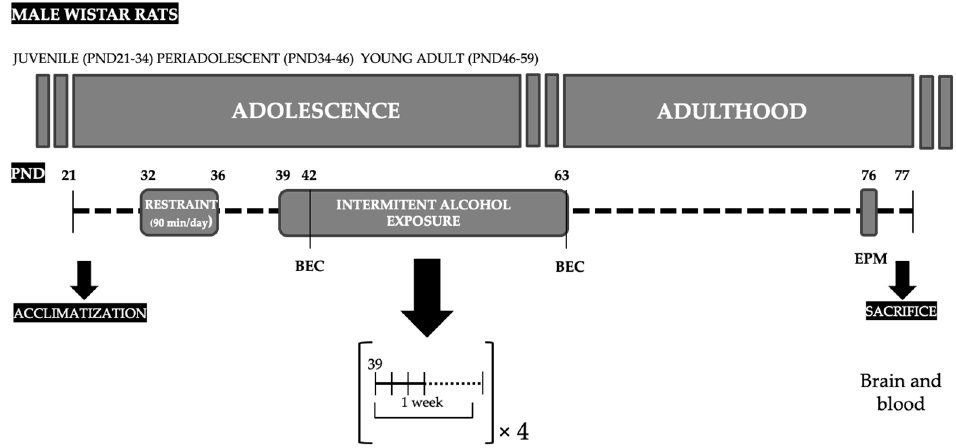
Figure 1. Experimental design of the study. Adolescent male rats were exposed to a repeated restraint stress (90 min/day for 5 consecutive days) from PND32 to PND36 followed by an intermittent alcohol exposure using a binge drinking procedure from PND39 to PND63. Ethanol solution was administered by intragastric gavage at doses of 3 g/kg, 4 days/week for 4 weeks. BEC values were determined 1 h after the alcohol administration at PND42 (last day of first week of alcohol exposure) and PND63 (last day of alcohol exposure). Spontaneous motor activity and anxiety-like behaviors were evaluated 2 weeks after the last administration of alcohol using the EPM. All animals were sacrificed at PND77, and brain and blood samples were collected for determinations. Abbreviations: BEC = blood ethanol concentration; EPM = elevated plus-maze; PND = postnatal day.